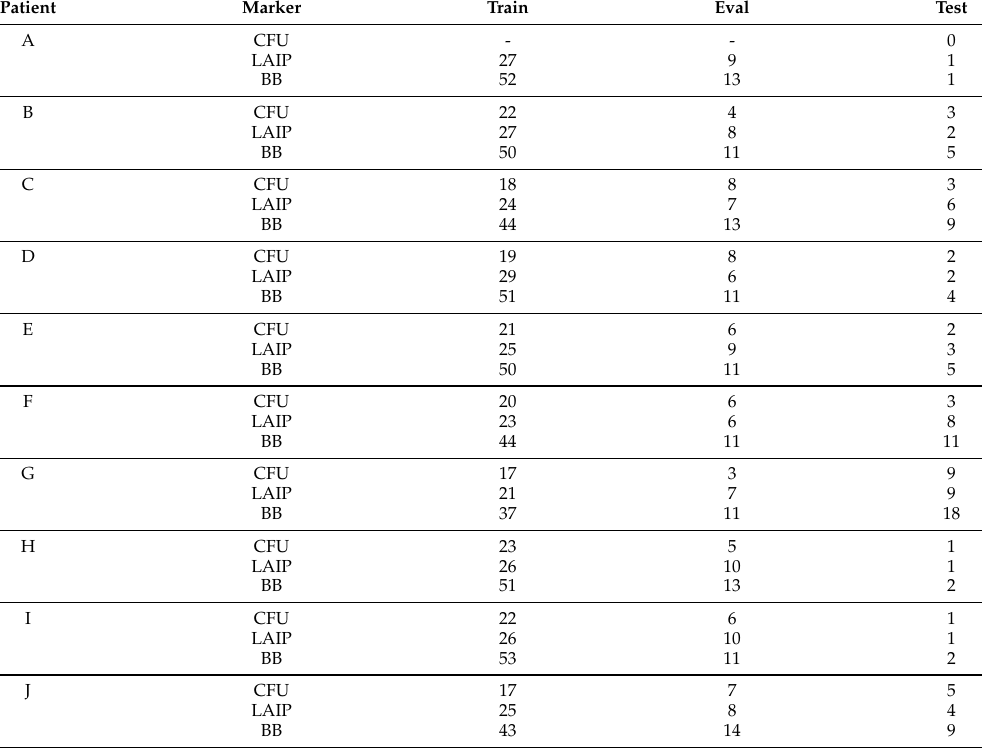
Table A6. Three experiments are performed separately, one with CFU data, one with LAIP data and one with backbone (BB) data. Available data sets are splitted into training, evaluation and test set. Each patient generates one split because the patients samples are hold out as test data (meaning that the rightmost column corresponds to the number of CFU, LAIP and backbone samples of each patient). All remaining samples from other patients are divided into training and evaluation